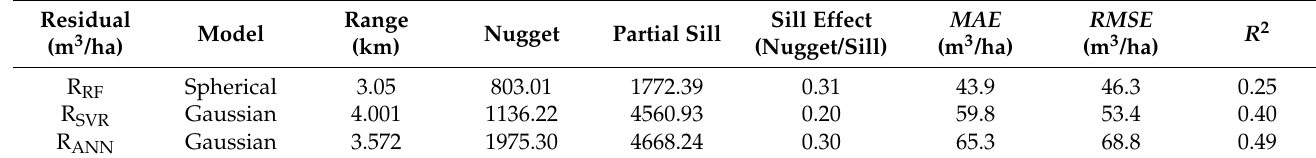
Table 5. Estimation accuracy evaluation of machine learning models and ordinary Kriging model hybrid.